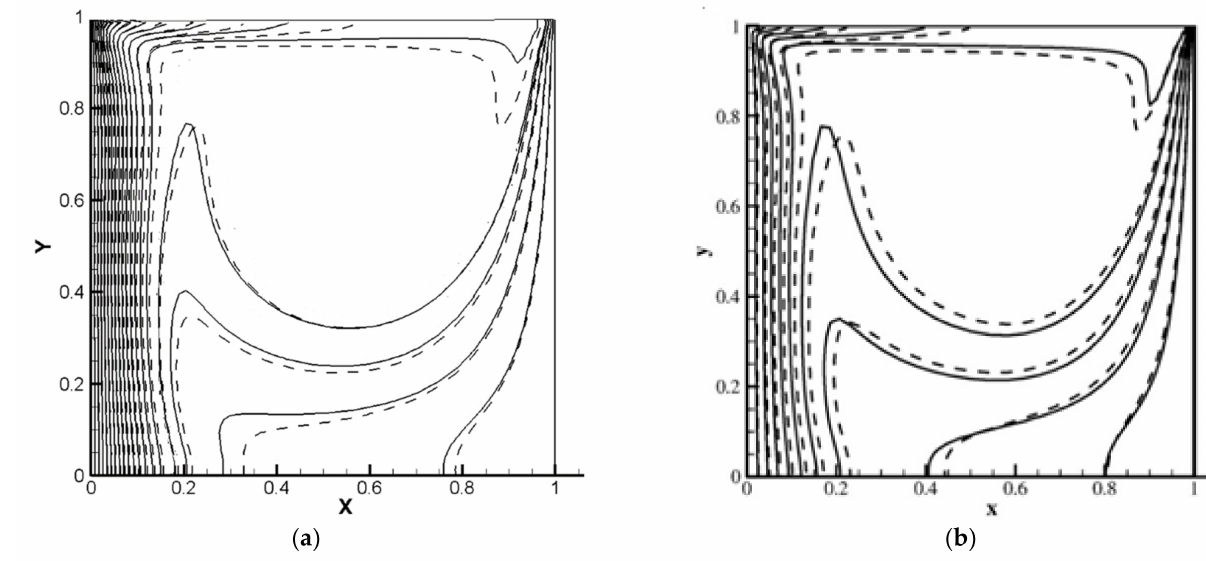
Figure 3. Isotherms for Re = 100 and Ra = 1.47 × 10 4 : ϕ = 0 ——–, ϕ = 0.05 ——-. ( a ) Current study; ( b ) Talebi et al. [23].